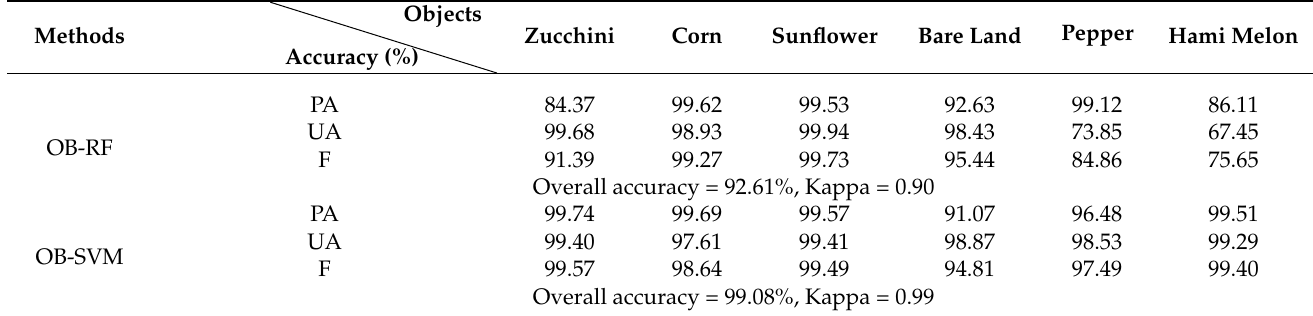
Table 8. Accuracy evaluation of classification results for SA2.